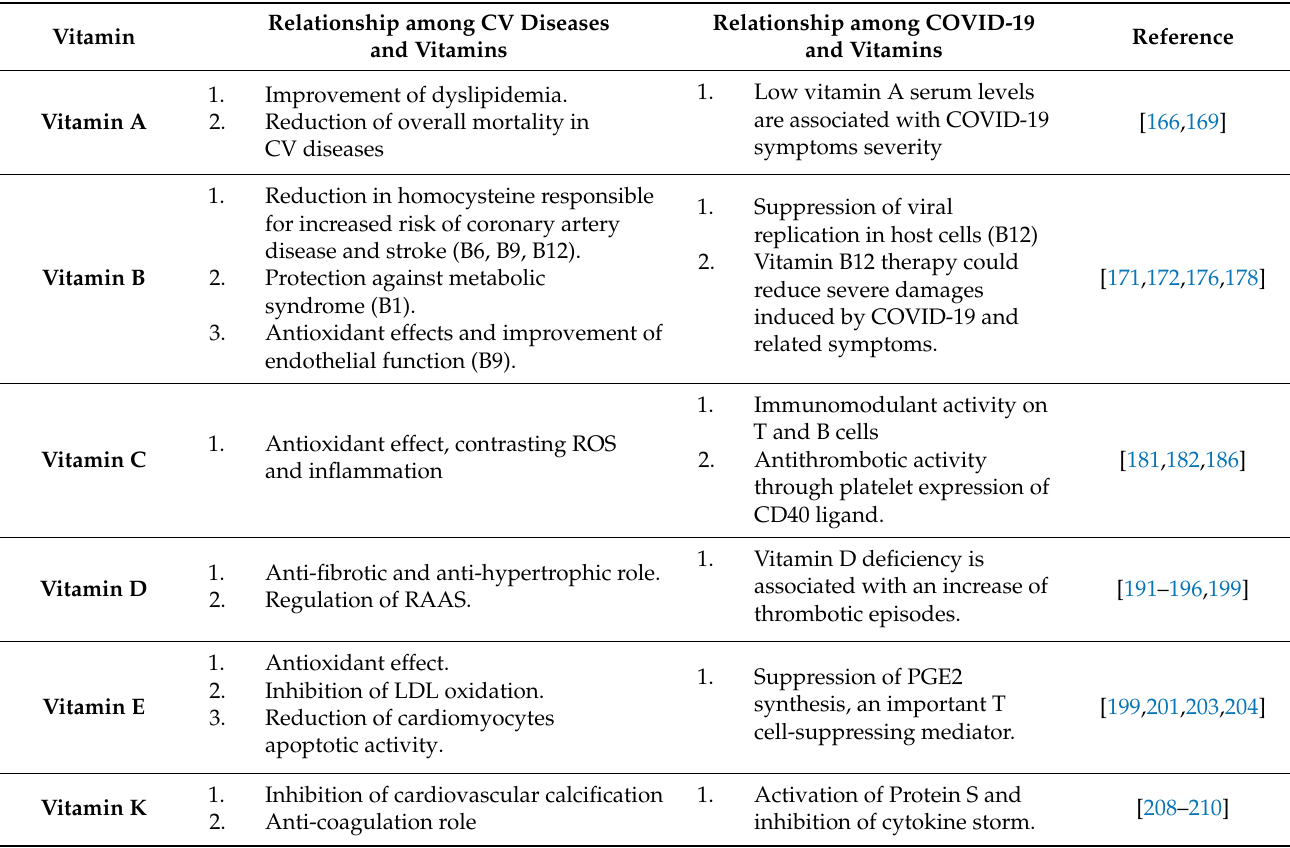
Table 2. A summary of the most important vitamins imbalance during COVID-19 and their effects on CV